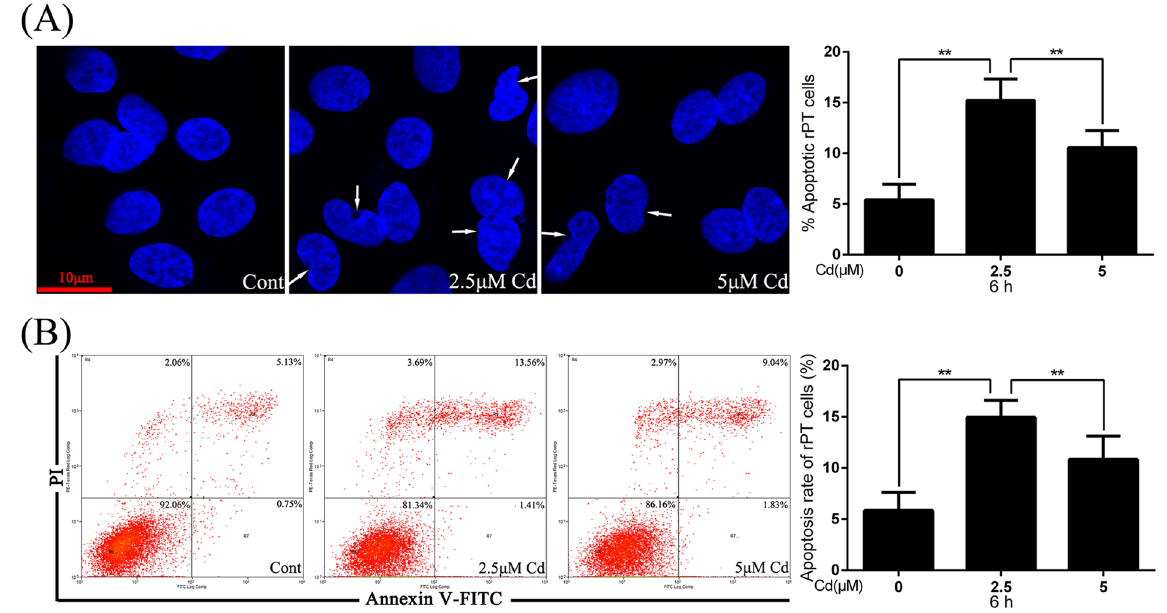
Figure 2. Effects of Cd on apoptosis of rPT cells. (A) Cells were incubated with 0, 2.5, and 5 μ M Cd for 6 h and nuclear chromatin changes (apoptosis) were analyzed by confocal microscopy after DAPI staining. Changes of nuclei fragmentation with condensed chromatin are indicated by white arrows. The quantified results are expressed as mean ± SEM of three separate experiments, each performed in triplicate (n = 9). (B) rPT cells were treated with Cd for 6 h and apoptosus was assessed by flow cytometry. Data are presented as mean ± SEM of three separate experiments, each one performed in triplicate (n = 9). * P < 0.05 and ** P <